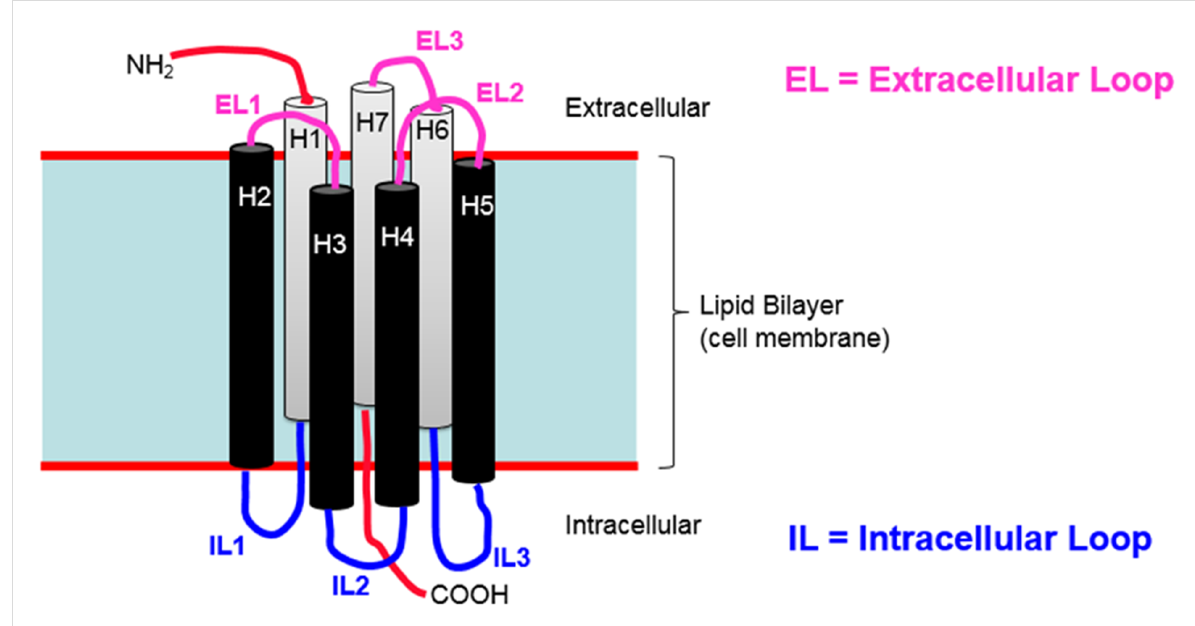
Figure 2: A schematic diagram of the general structure of GPCRs. Most GPCRs also contain an eighth helix, H8, at the C-terminus (not shown in the